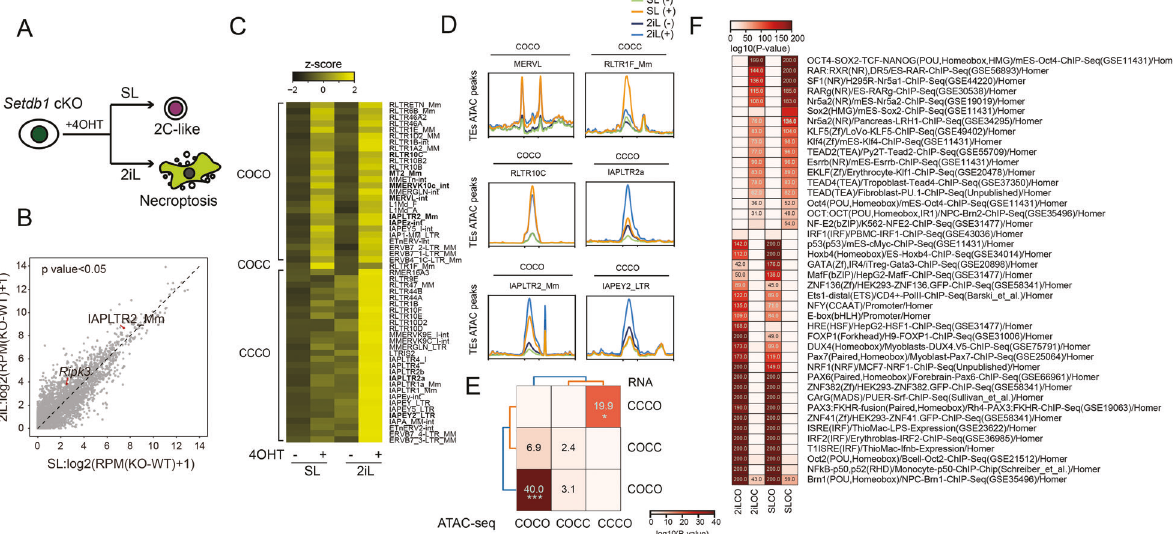
Fig. 3 IAP elements are enriched in Setdb1 -KO mediated necroptosis related TEs enrich. A Cell fate model of Setdb1 KO mESCs under SL and 2iL conditions. B Volcano plot of upregulated genes and TEs in 2iL and SL culturing conditions. C Heatmap pro fi le from ATAC-seq analysis classi fi es TE expression of Setdb1 CKO cells upon SL or 2iL condition into 3 clusters (COCO,COCC and CCCO). D Read-count tag density pileups of ATAC pro fi les on representative TEs in cluster “ COCO ” , “ COCC ” , ” CCCO ” . E A heatmap displays the enrichment of ATAC-seq clusters in RNA de fi ned clusters. Signi fi cance is derived from a Fisher exact test. F Heat map of different transcription factors ’ motif analysis in 2iL CO/OC and SL CO/OC clusters (* p < e-10; ** p < e-20; *** p < e-30).